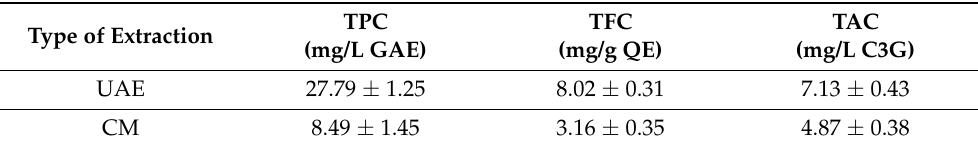
Table 1. Total phenolic (TPC), flavonoid (TFC), and anthocyanin (TAC) content of the raspberry fruit pomace (RFP).